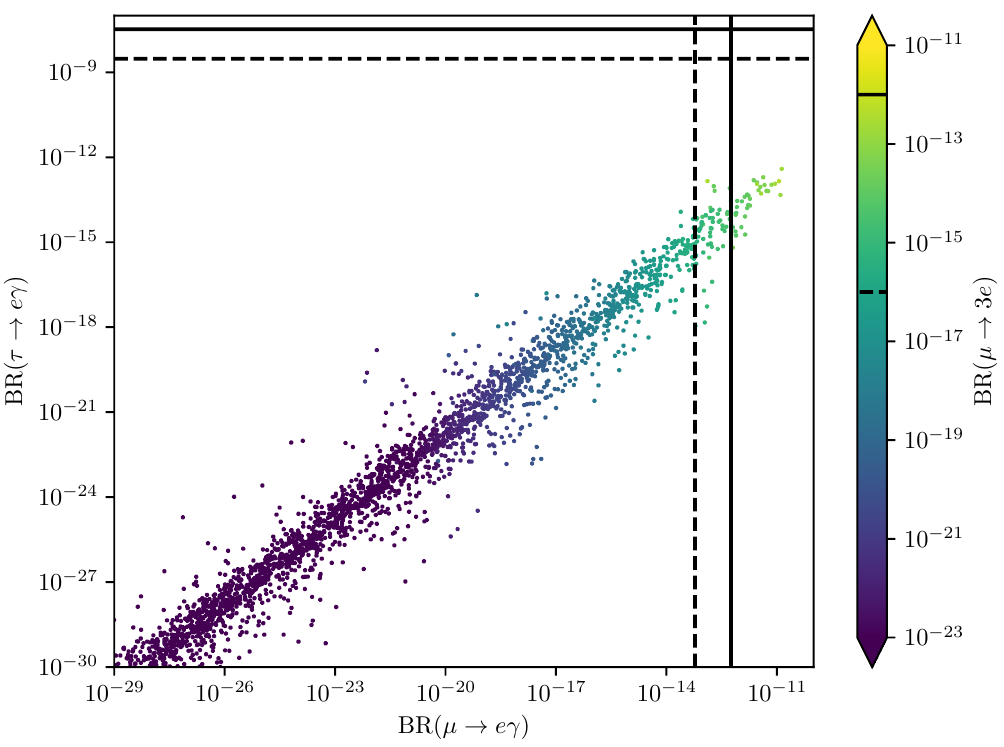
Figure 12 . Correlations of the branching ratios for the LFV processes (cid:22) for viable models with triplet scalar DM. Also shown are current (full lines) and future (dashed lines) exclusion limits [41, 42,